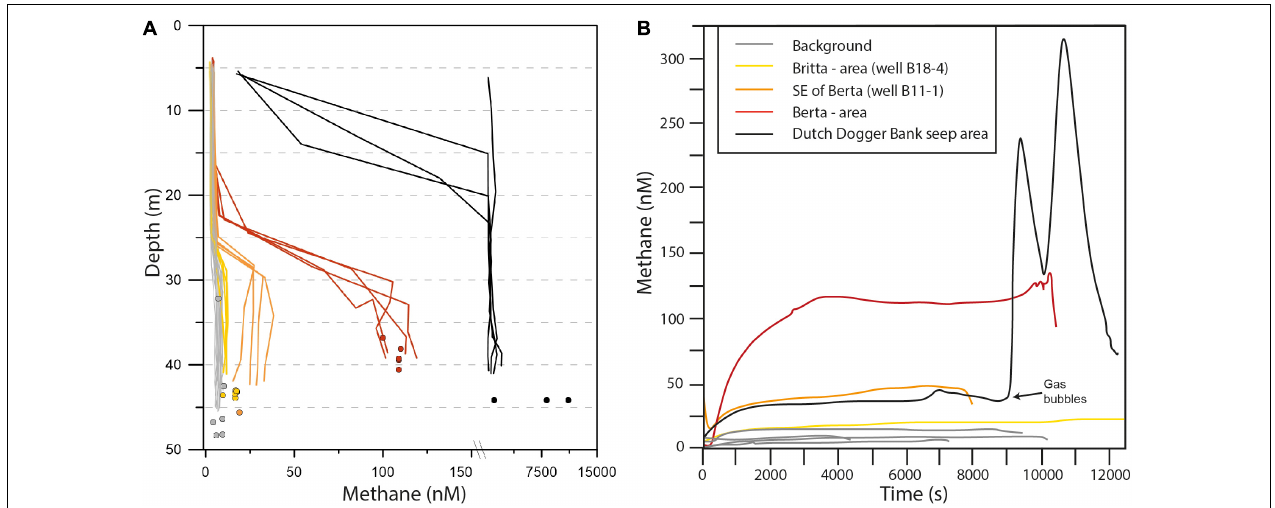
FIGURE 4 | (A) Profiles of methane in the water column of the “Entenschnabel” study area and for comparison of the Dutch Dogger Bank seep area (Please note break in the x -axis to address the different ranges of methane concentrations) as well as of concentrations in bottom waters (dots, MIC water samples) close to water column stations. Light gray samples represent background values at the reference site at salt diapir Birgit and four abandoned wells (wells B15–1, B15–2, B15–3, and B11–3). (B) Methane concentrations measured with the METS during towed deployments in seven areas in the “Entenschnabel” and the Dutch Dogger Bank seep area while passing a known flare cluster for